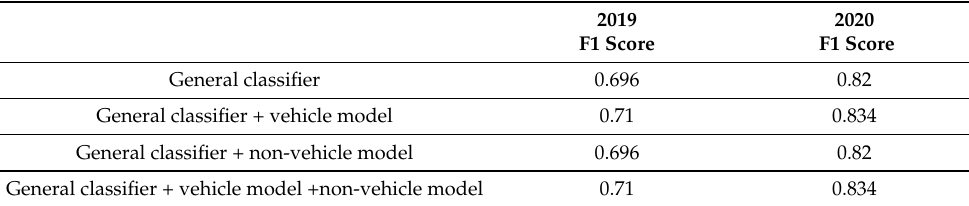
Table 8. The F1 scores obtained when the vehicle and non-vehicle models are combined with the general classifier. This table illustrates whether the vehicle and non-vehicle models introduce any improvement over the general classifier.